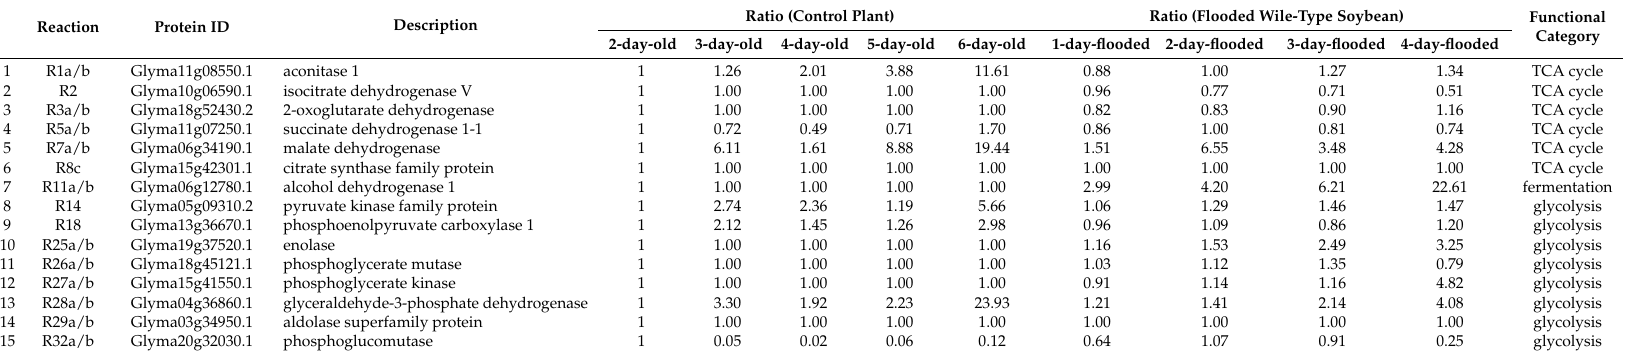
Table 1. Ratio of proteins related to glycolysis, fermentation, and tricarboxylic acid cycle in wild-type soybean plants under flooding conditions. Reaction